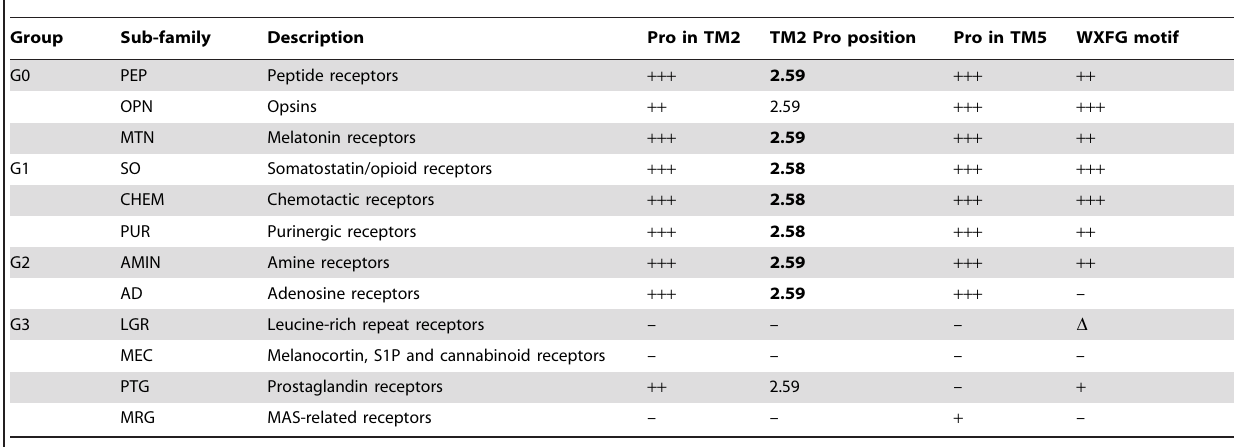
Table 1. Summary of the human GPCR set.